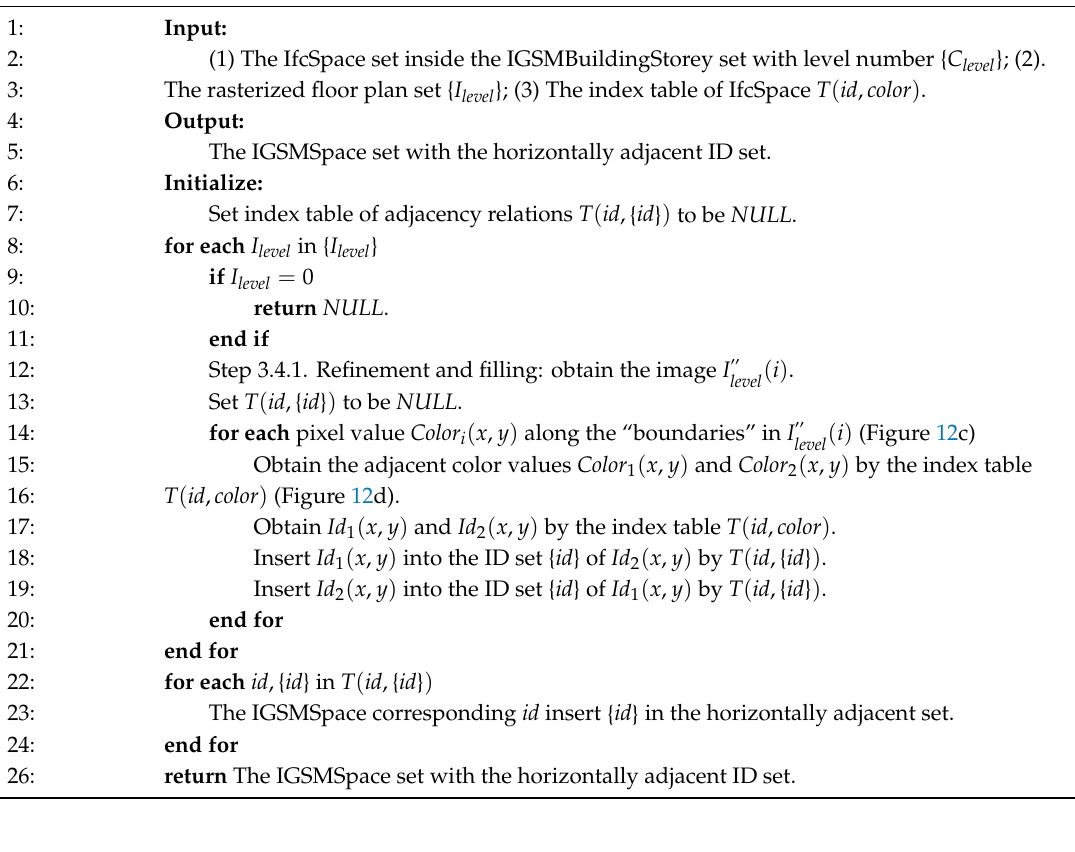
Algorithm 7. Horizontal Search